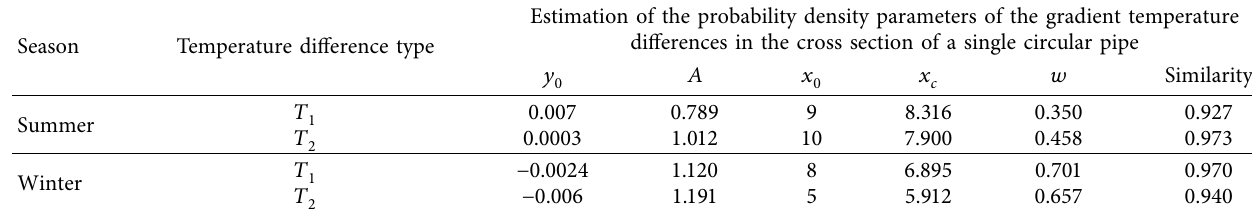
Table 4: Estimated parameters of probability density statistical model.